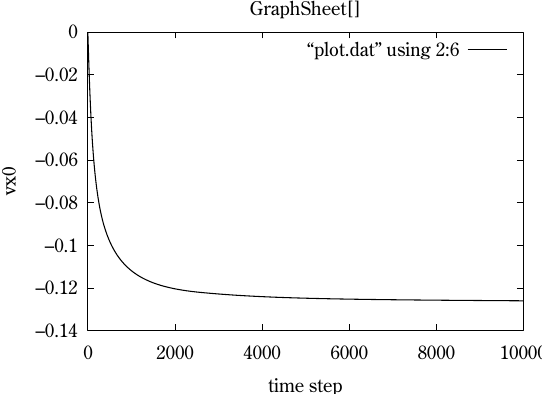
Fig. 4 Evolution of the migration velocity of a colloidal particle over